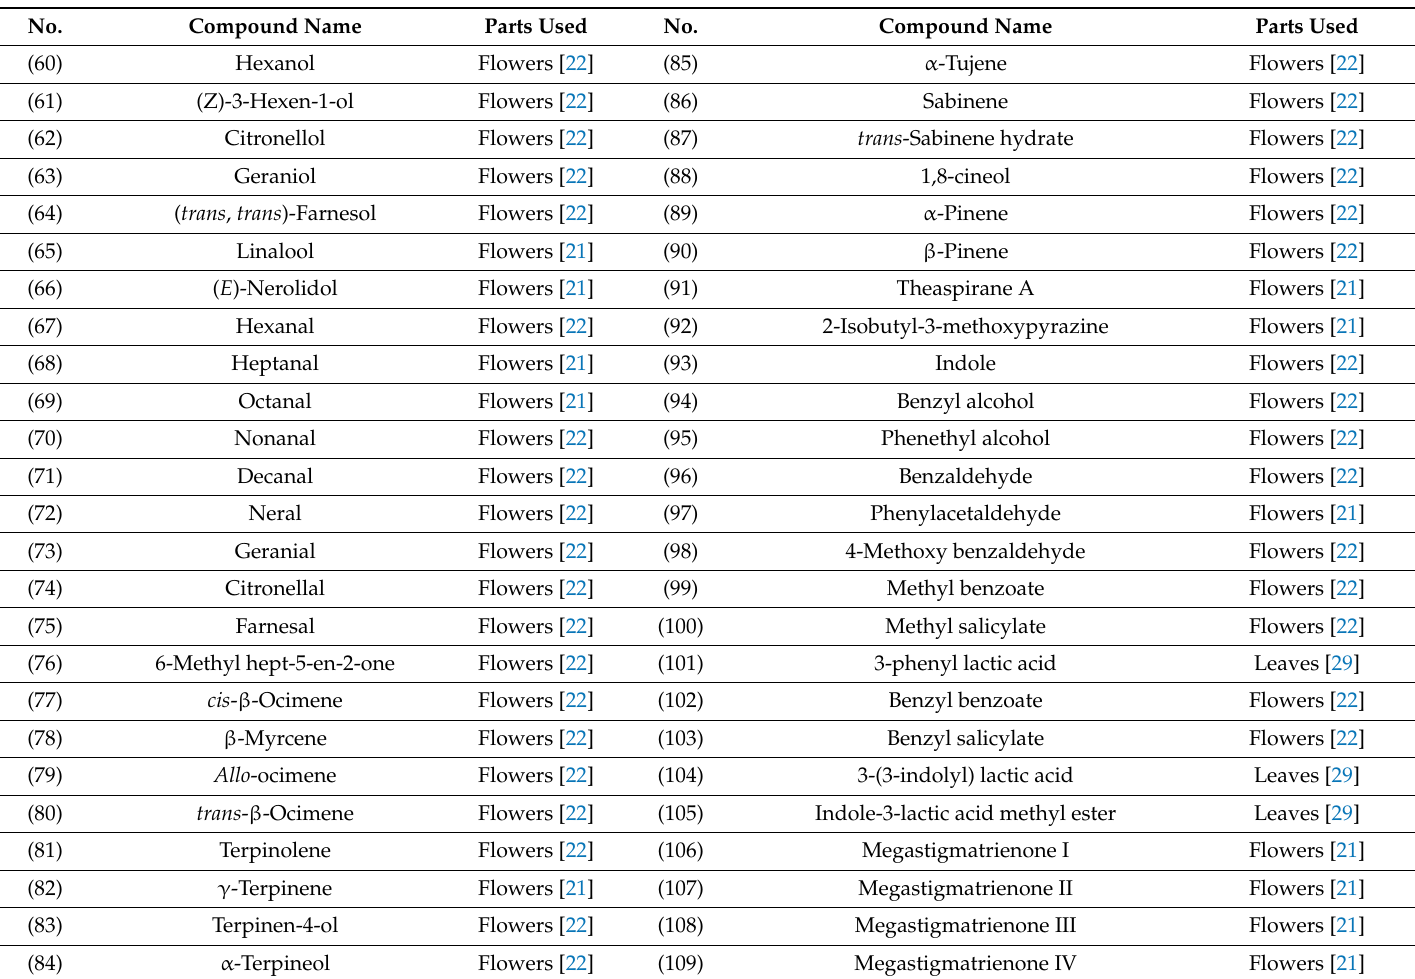
Table 3. Volatile Compounds from Brugmansia suaveolens